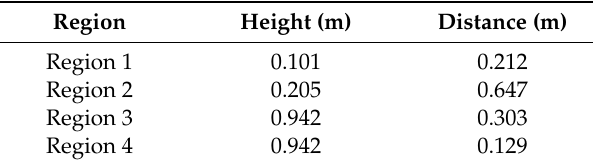
Table 6. Obstacle detection